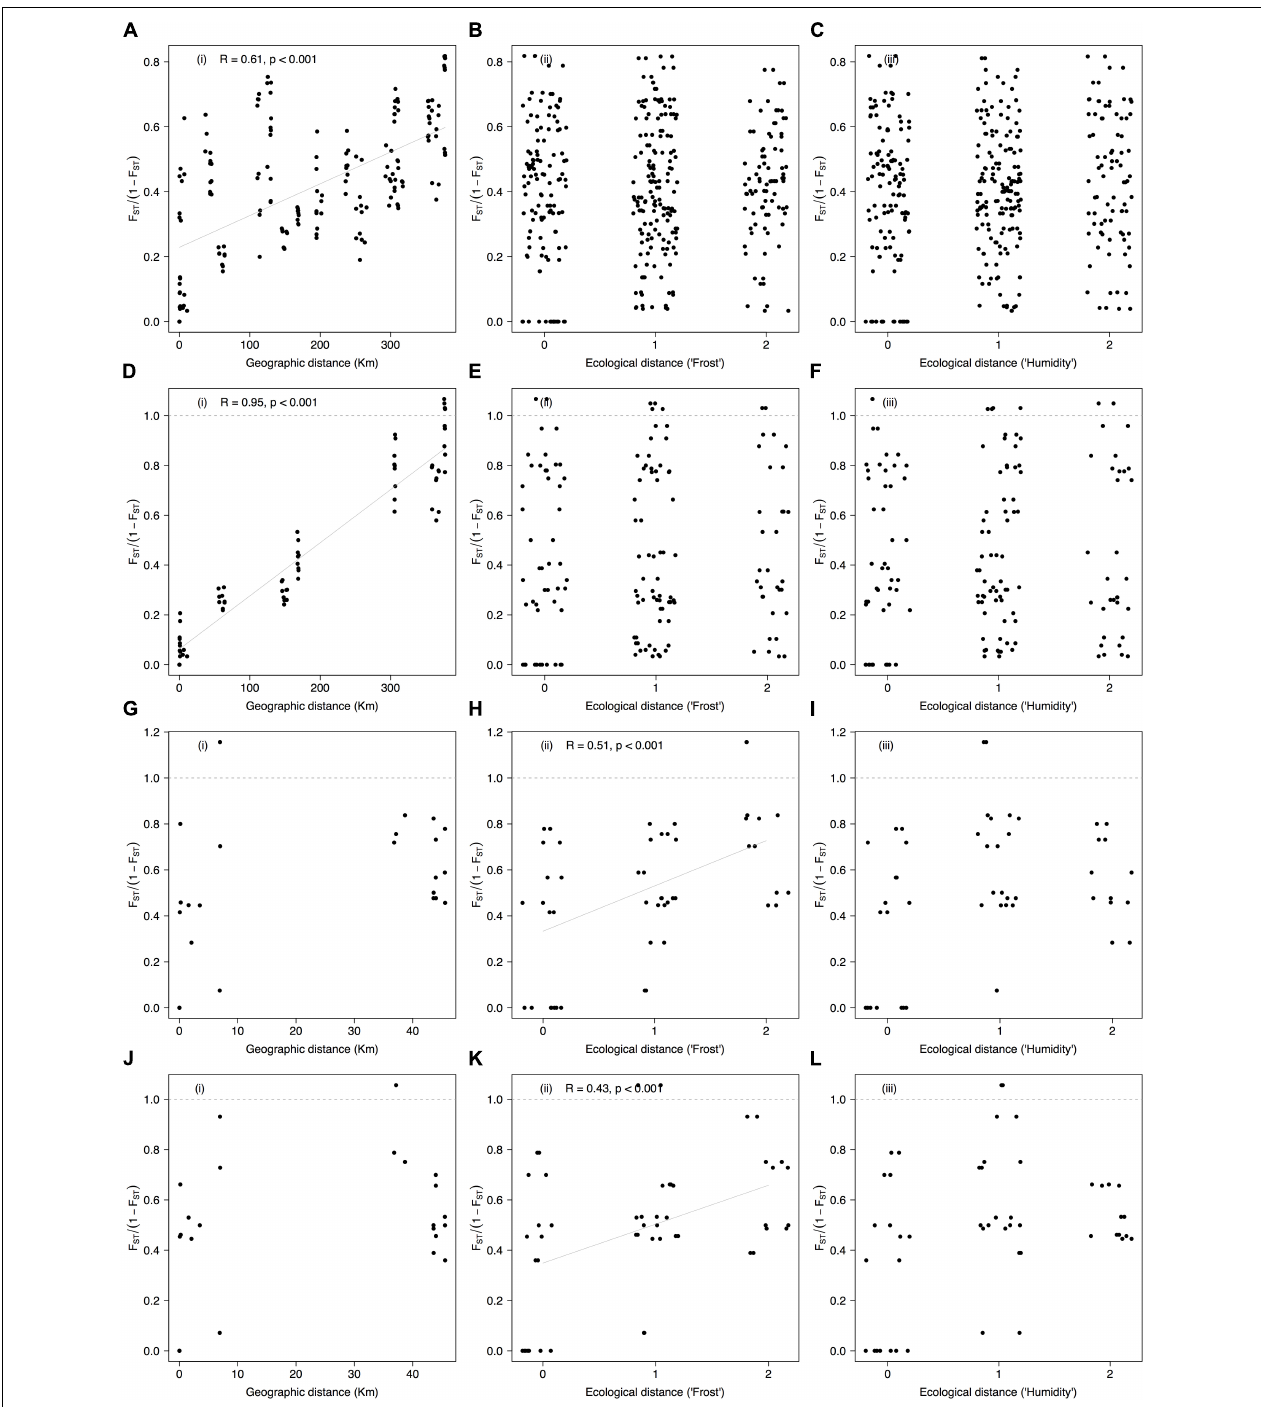
FIGURE 6 | Correlations between genetic differentiation, geographic distance, and ecological distance (exposure to frost and soil moisture content) among populations of Espeletia growing in three different habitats and six localities. First column of diagrams show F ST /(1 – F ST ) vs. geographic distance (A,D,G,J) , following Rousset (1997), while second and third columns show F ST /(1 – F ST ) vs. ecological distances based on the theoretical (as coded in Supplementary Table S1 ) exposure to frost (B,E,H,K) and soil moisture content (C,F,I,L) , respectively. The first row of the diagrams are based on the entire dataset (A–C) , second row only include contrasting populations and markers significantly associated with the localities (D–F) , and third and fourth rows only include contrasting populations for habitats and markers significantly associated with the theoretical exposure to frost (G–I) and the theoretical soil moisture content (J–L) , respectively. Allelic associations of the GBS-derived SNP markers with localities and habitats were quantified using 18 different general and mixed-effects statistical models that accounted for phylogenetic distance. Only results for the optimal models are shown. Lines are displayed where Mantel tests were significant according to Table 1 .